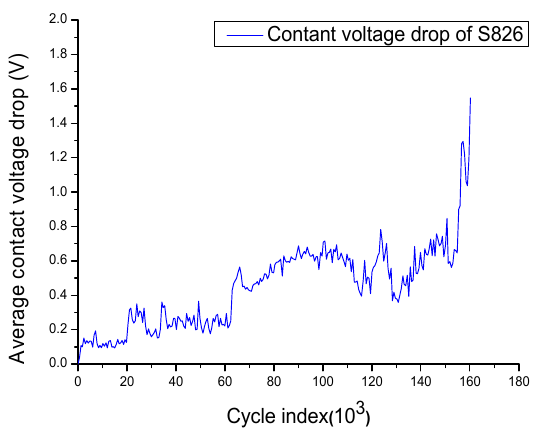
Figure 4. Dynamic contact voltage drop of S826.